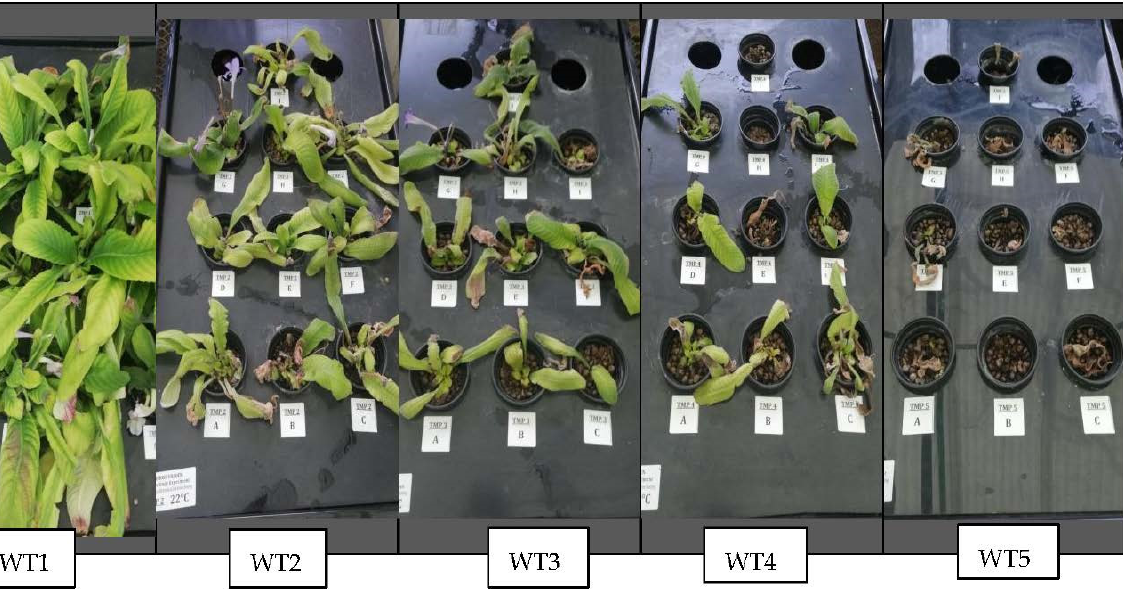
Figure 5. The relationship between root zone water temperature treatments and the relative rates of increase and decrease in root length. 3.4. Total Fresh Weight Combined root and leaf fresh weights, as shown statistically in Table 2, were signifi- cantly affected by the root zone temperature ( F 1,4 = 23.75, p ≤ 0.0001), and the results show that incremental increases in water temperature treatments from 18 °C to 34 °C decreased fresh weight, to the point of notable fatality at the highest temperatures of 30 °C and 34 °C, clearly visible in Figure 4. The WT1 (18 °C) treatment offered the highest significant increase in overall fresh weight and vegetative growth when compared to the control WT3 (26 °C) and all the other treatments: WT2 (22 °C), WT4 (30 °C) and WT5 (34 °C). Findings -60 -50-40-30 -20